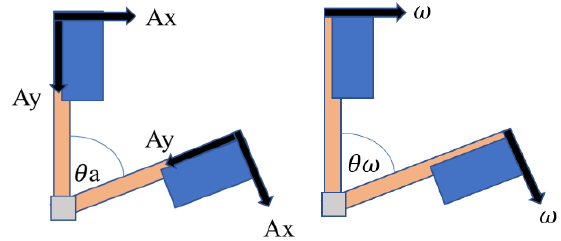
Figure 7. The acceleration angle (left); the angular velocity angle (right).